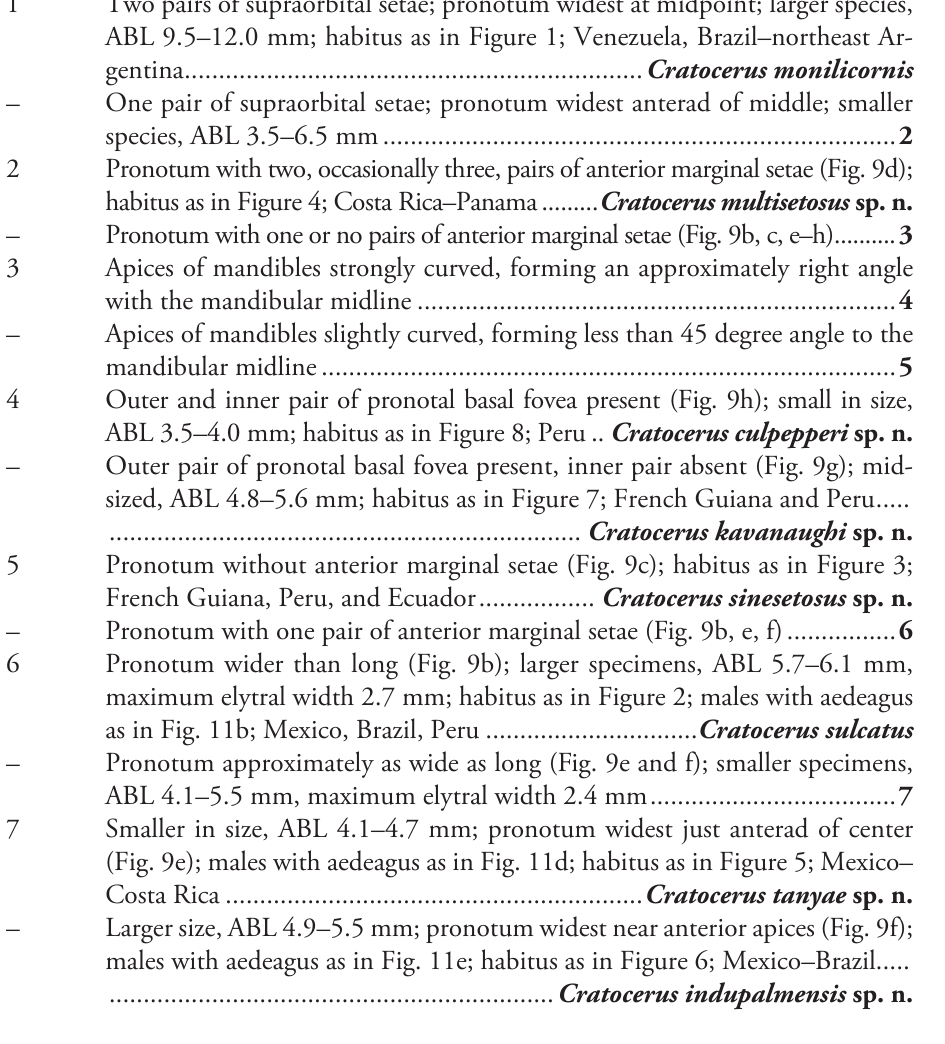
Two pairs of supraorbital setae; pronotum widest at midpoint; larger species, ABL 9.5–12.0 mm; habitus as in Figure 1; Venezuela, Brazil–northeast Ar- One pair of supraorbital setae; pronotum widest anterad of middle; smaller Pronotum with two, occasionally three, pairs of anterior marginal setae (Fig. 9d); habitus as in Figure 4; Costa Rica–Panama ......... Cratocerus multisetosus sp. n. Pronotum with one or no pairs of anterior marginal setae (Fig. 9b, c, e–h) .......... 3